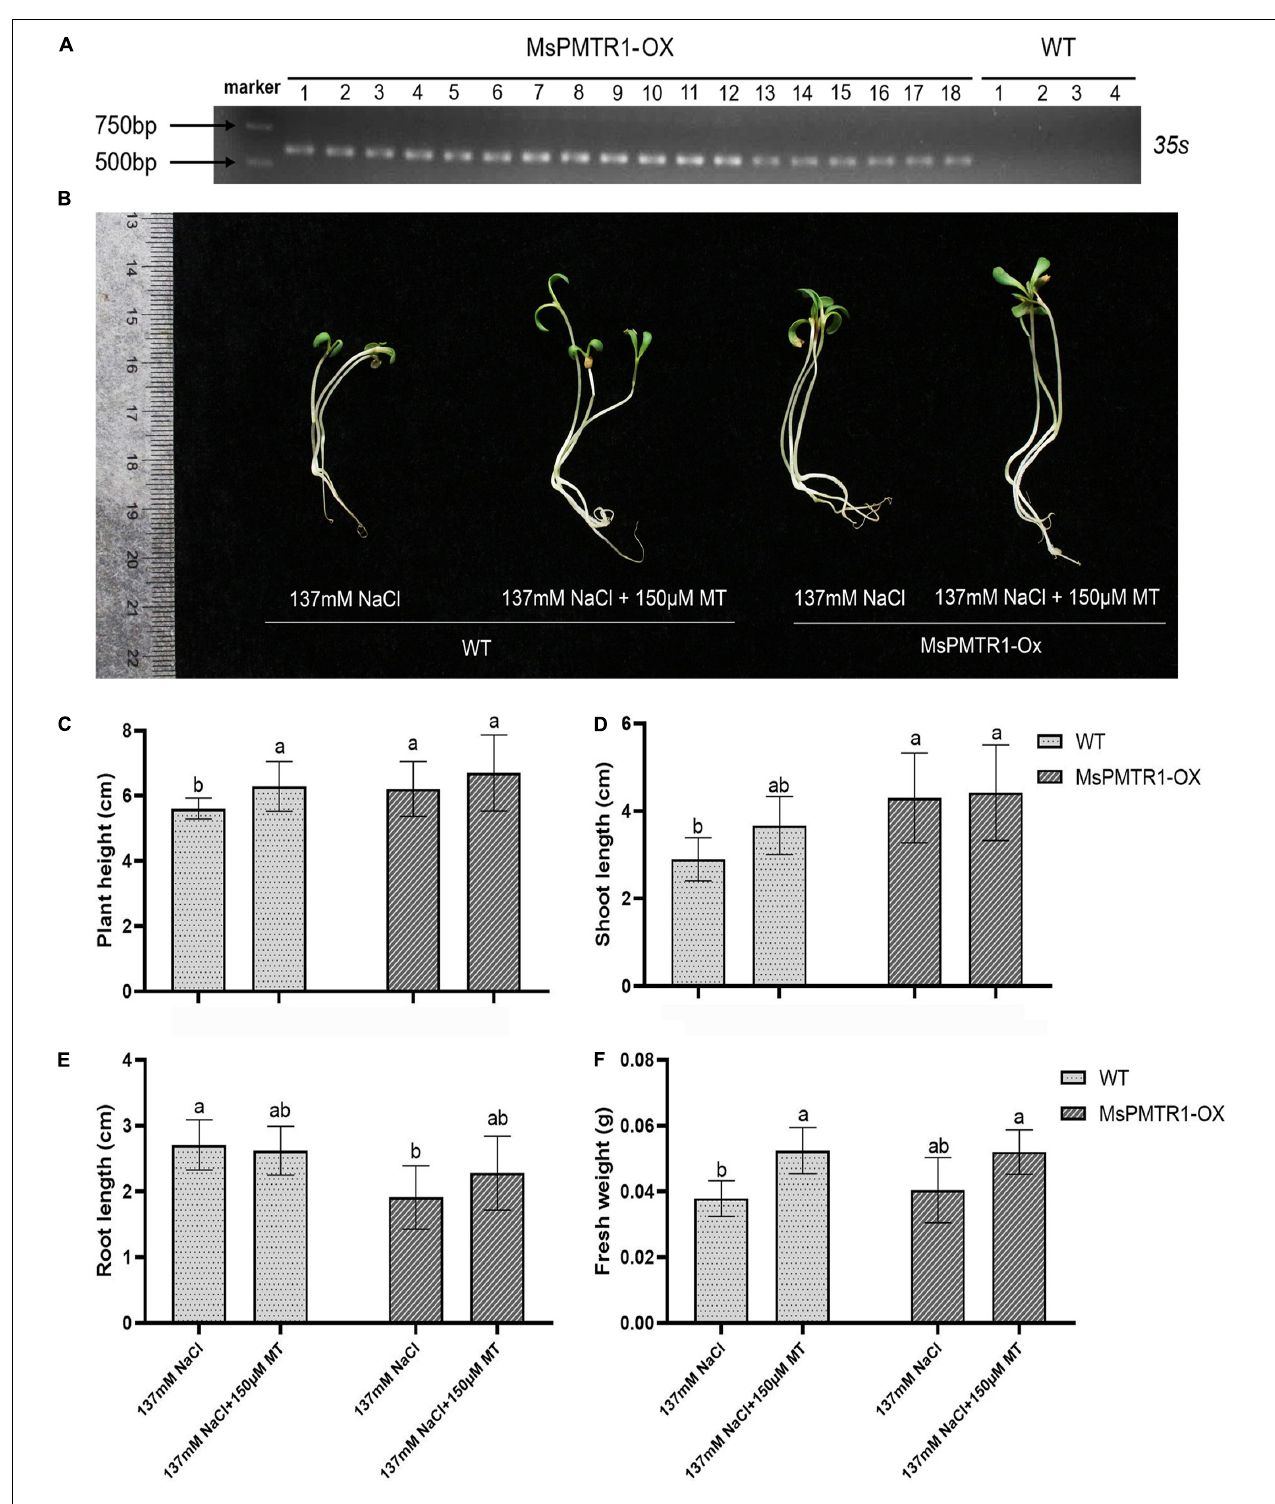
FIGURE 9 | Stable overexpression of MsPMTR1 in M . truncutula and phenotypic analysis of transgenic lines under salt stress. (A) PCR detection of transgenic alfalfa lines. Different lines are indicated. WT, wild-type alfalfa cultivar R108. The sizes of DM2000 markers are shown on the phenotype of a representative individual from transgenic and wild-type plants under NaCl and MT treatment. (C–F) plant height, shoot length, root length, and fresh weight. Three biological replicates were performed for each assay. Error bars show the SE between biological replicates and a t -test was performed between different treatment groups. Different numbers indicate significant differences ( p (cid:53) 0.05) between different